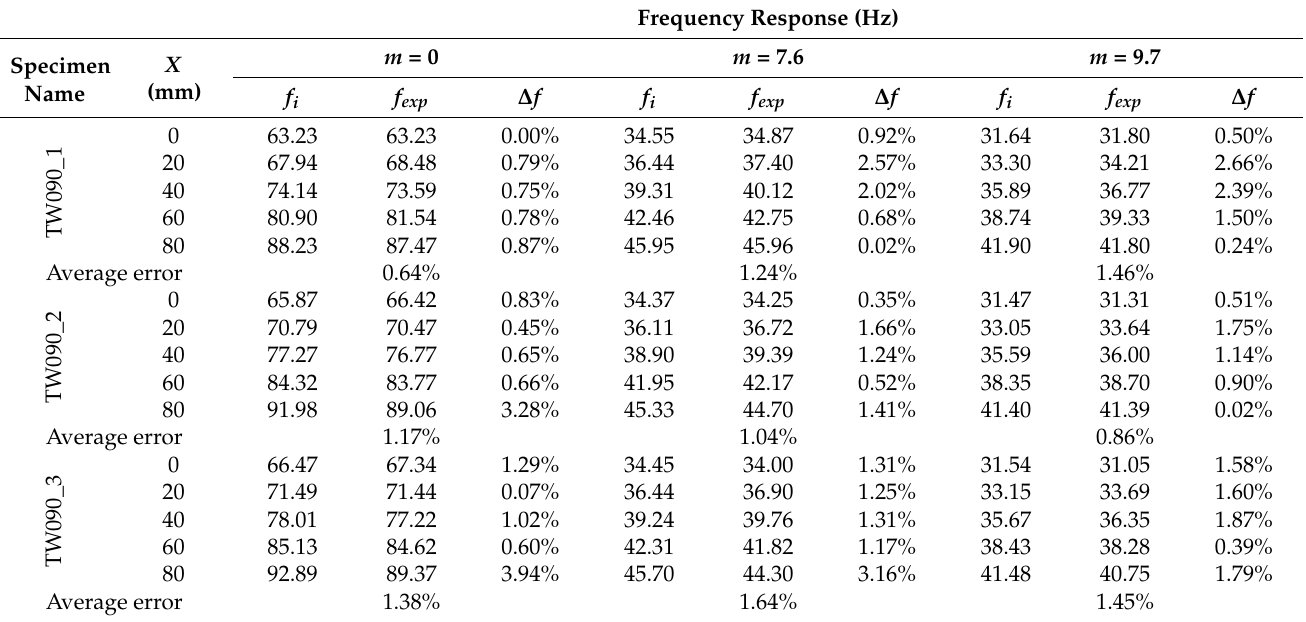
Table 4. Comparison of estimated resonance frequencies with experimental tests for all cases of cantilever beam.